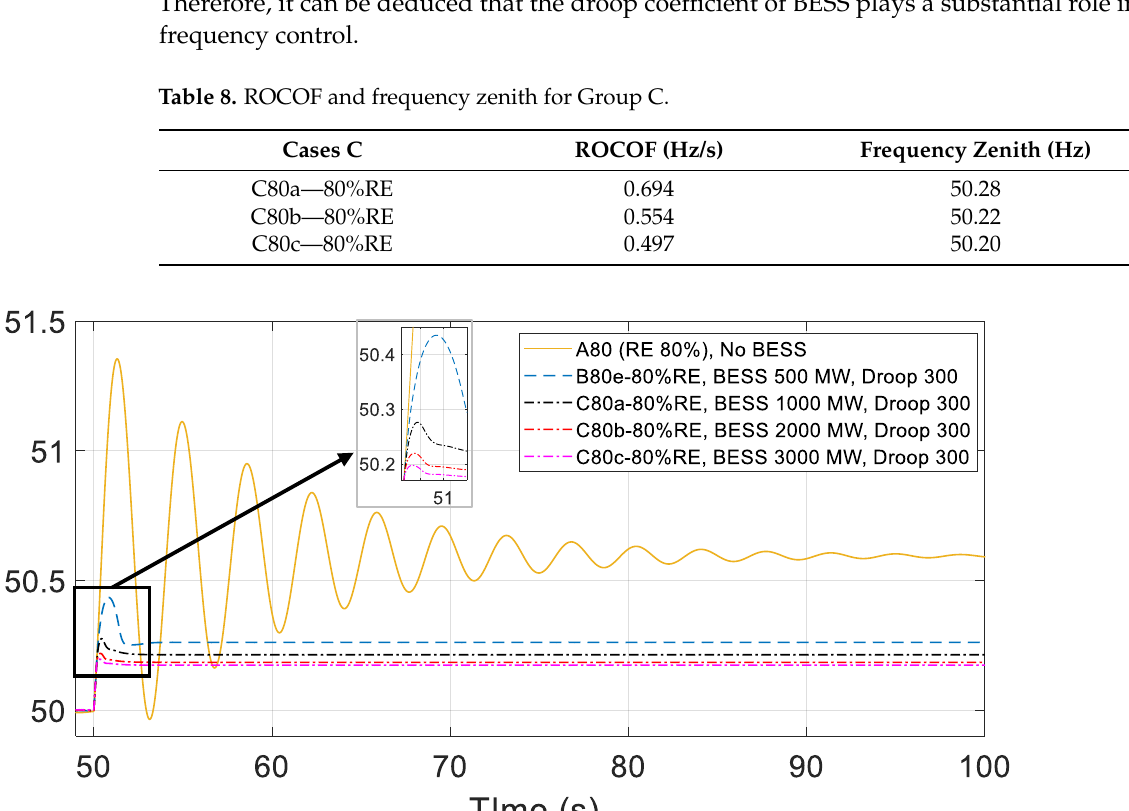
Figure 11. BESS output power with a variation in BESS capacities. To further examine the impact of the capacity of BESSs and droop coefficient on PFC, 22 different values of droop coefficient, and 22 different capacities of BESS were investi- gated. This method was applied for demonstrating the comparison of the capacity of BESS with varying characteristics of droop. As depicted in Figure 12a, frequency settling time decreases with the increasing capacity of BESS and droop coefficient. However, for a lower capacity of BESS, when droop coefficient exceeds a critical value, a changing rela- tionship between droop coefficient and frequency settling time can be observed. For ex- ample, as shown in Figure 12a, 100 MW BESS with a droop coefficient of 1000 increases